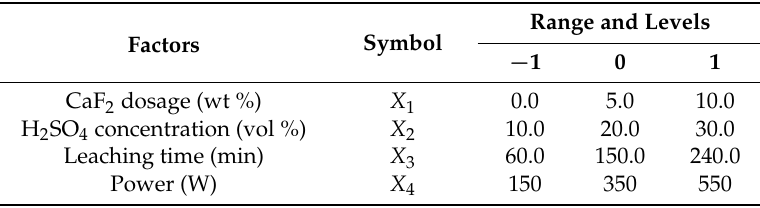
Table 3. Independent factors and levels used for